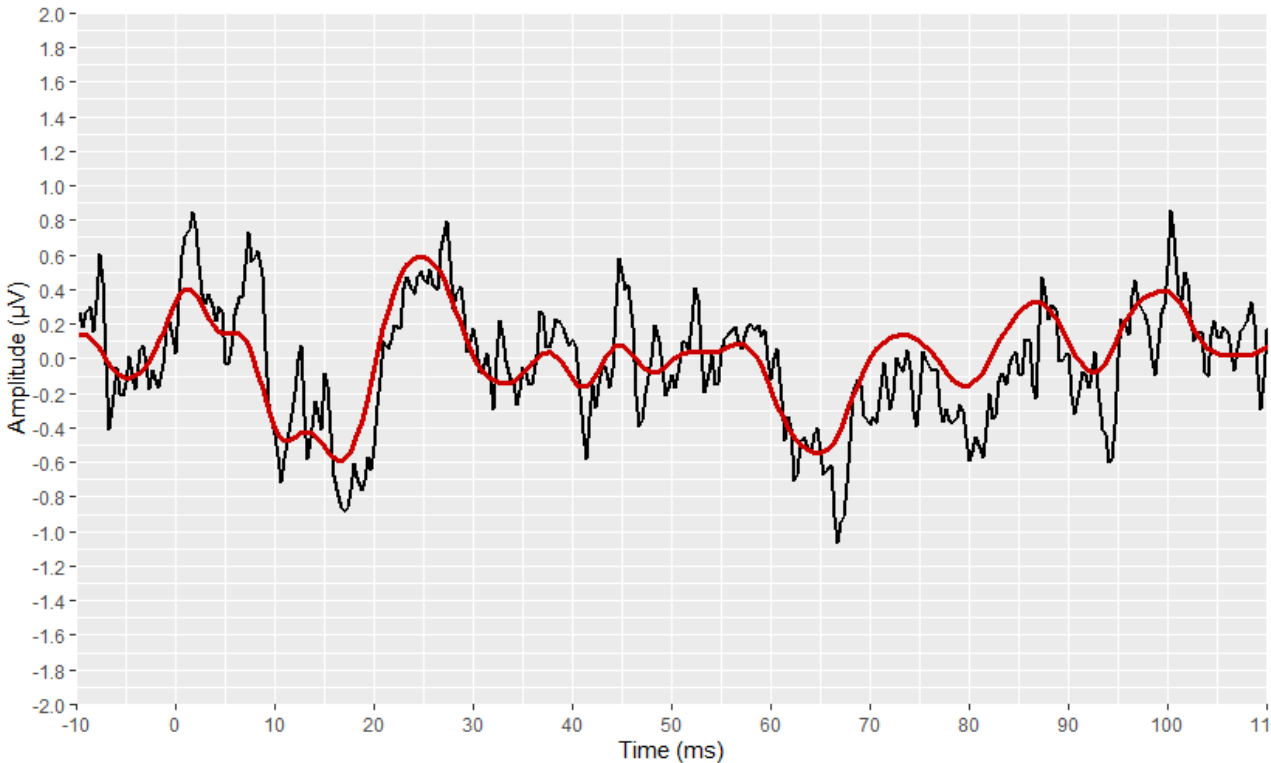
Figure 4. Visualisation of an ABR waveform from raw data (in black).